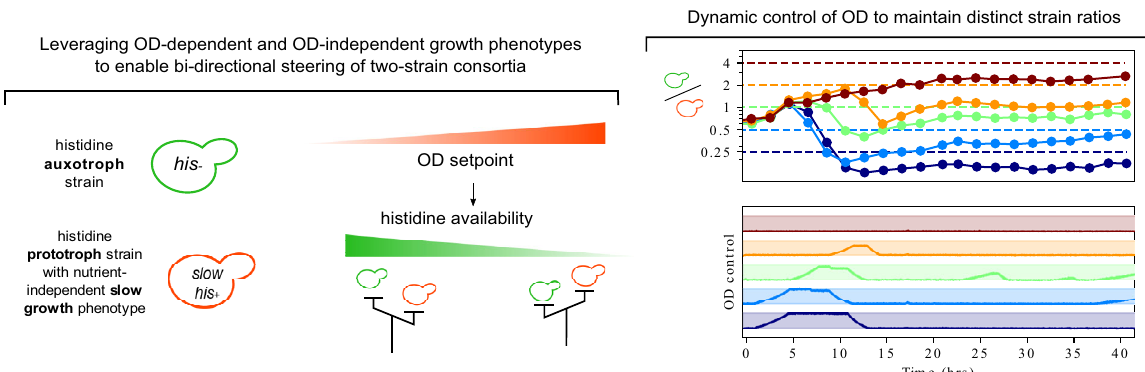
Fig. 4 Exploring and exploiting the relationship between fi tness, nutrient scarcity and cellular stress. a Experiments combining single-cell genotyping and phenotyping are made possible thanks to co-cultures, automated cytometry and reactive experiment control to adapt environmental conditions in real- time. b Top-left: the availability of essential nutrients (such as histidine for his3 mutant strains) depends on the environmental supply but also on cell density via nutrient consumption. Low nutrient availability will impede growth rate and might trigger cellular stress. Top-right: experiment design. Wild- type cells (marked with mCerulean constitutive expression) are co-cultured with his3 mutant cells. Both strains harbor a UPR stress reporter construct driving expression of mScarlet-I. Automated cytometry enables to assign single cells to their genotype (Supplementary Fig. 13) and to monitor strain- speci fi c UPR activation. The dynamics of the relative amount of the two strains allows inference of the growth rate difference between mutant and wild- type cells for each condition. Bottom left: cell density dependence of the fi tness de fi cit of mutant cells at two different media histidine concentration. The dashed line indicates the approximate dependence of wild-type growth rate on the OD setpoint. Bottom-right: strain-speci fi c UPR activation for each condition. c Left: principle for a two-strain consortium whose composition can be steered using control of OD. Right: implementation and demonstration. The secretion of a heterologous dif fi cult-to-fold protein is used as a nutrient-independent slow-growth phenotype. Dynamic control of the OD setpoint is performed using model-predictive control and the ReacSight event system, similarly to Fig. 3b (see Methods). Blue light was started at time 0 and was kept ON during the whole experiment to induce the slow-growth phenotype of the slow his + strain. We note the systematic presence of a steady-state error, with measured ratio below the target. In Supplementary Note 3, we investigate the mechanisms limiting the control performance (instability of the slow- growth phenotype, strain identi fi cation errors, and delays not accounted for in the model) and we also provide results of additional control experiments (Supplementary Figs. 14 – 17). Source data are provided as a Source Data fi